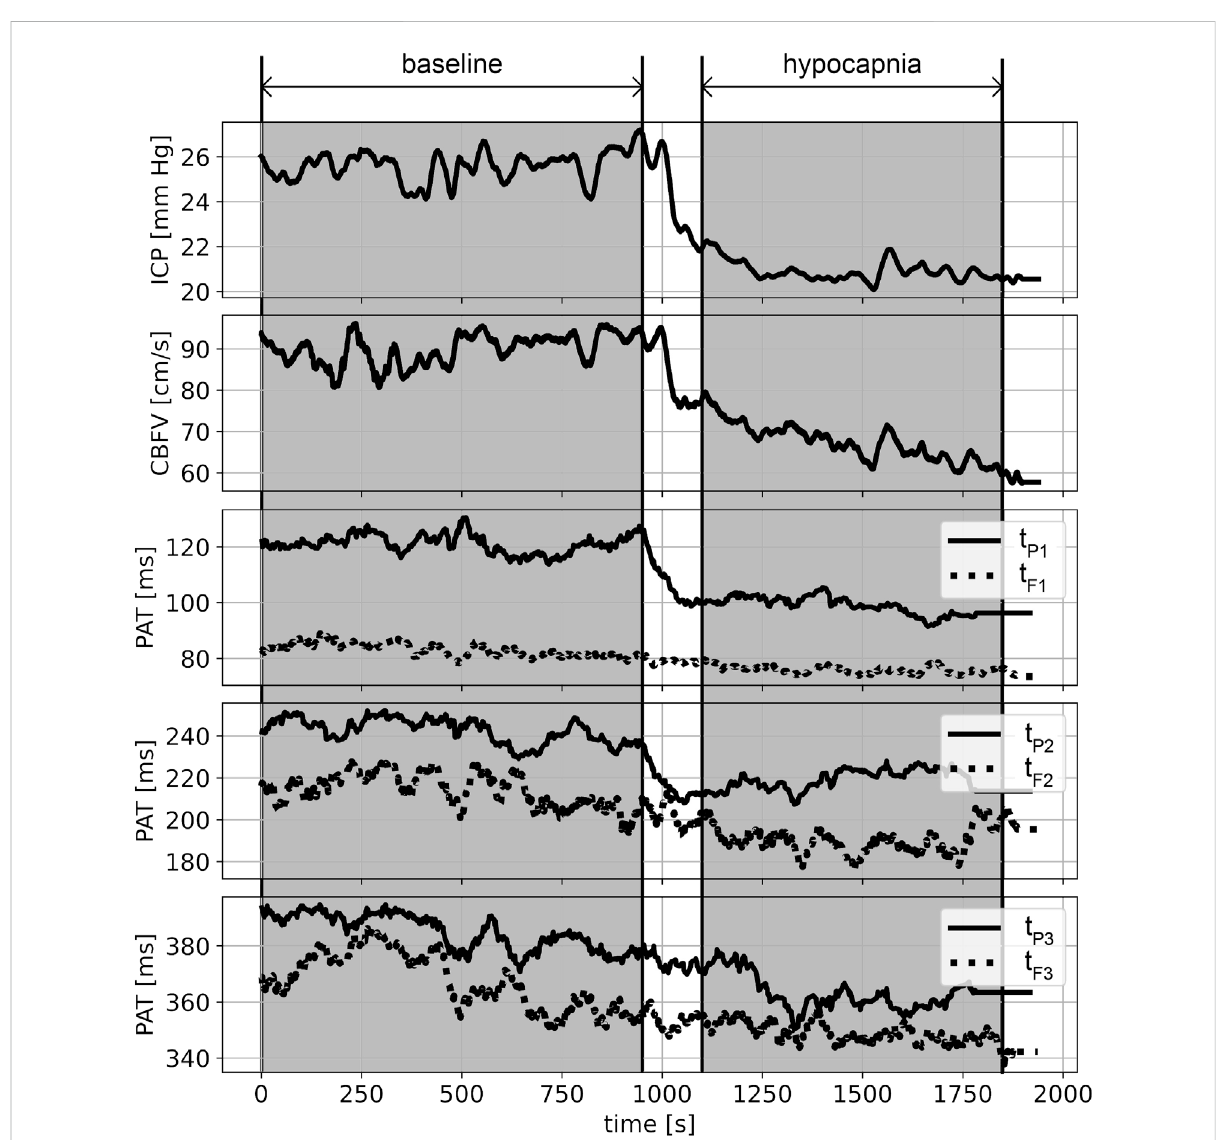
FIGURE 3 Anexampleofsmoothed(withinthewindowof40pulses)recordingsfromasinglepatientduringhypocapnia.Fromtoptobottom:intracranial pressure (ICP), cerebral blood fl ow velocity (CBFV), peak appearance times (PATs) of the fi rst, second, and third ICP peaks (t P1 , t P2 , t P3 ) and the fi rst, second and third CBFV peaks (t F1 , t F2 , t F3 ). Shaded areas indicate selected periods of baseline and